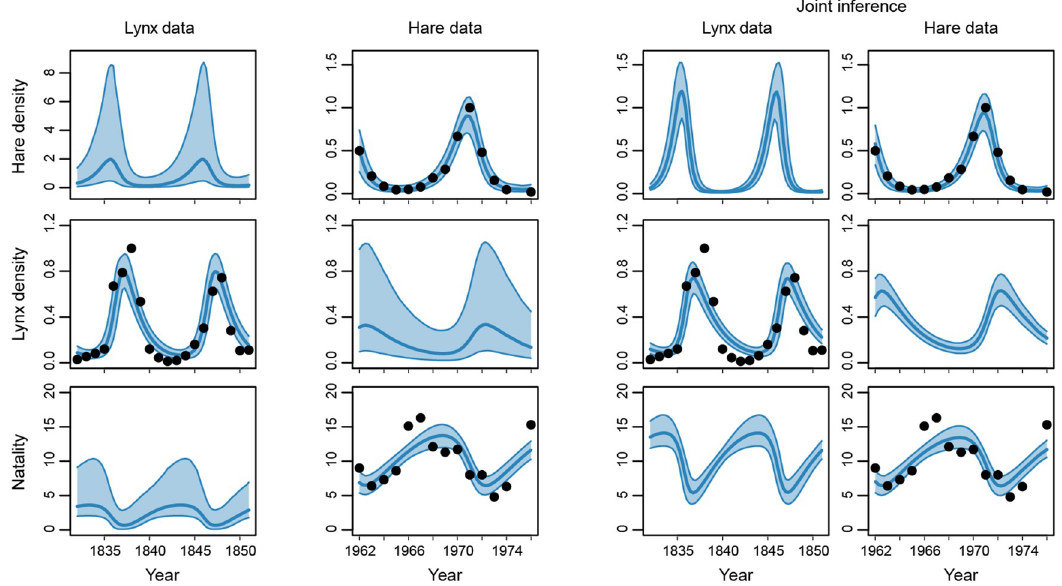
Fig 4. Lynx-hare datasets and posterior predictive distributions. The lynx data provides an estimate of lynx density (number of animals per surface area) and the hare data provides an estimate of hare density and natality. Black dots indicate the data, the thick blue line is the median and the shaded blue area the 90% confidence interval of the posterior